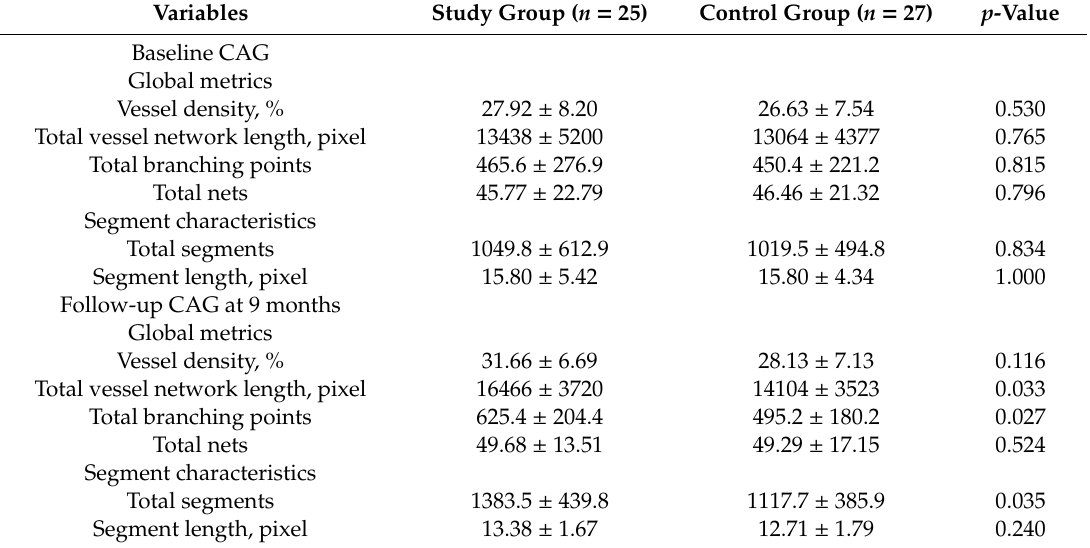
Table 3. Objective evaluation of angiogenesis with Wimasis software